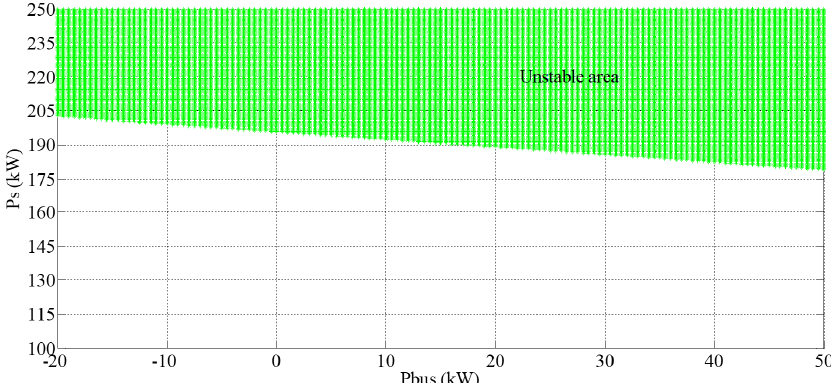
Figure 8. The power transfer boundary after applying the additional control based on the ESS.